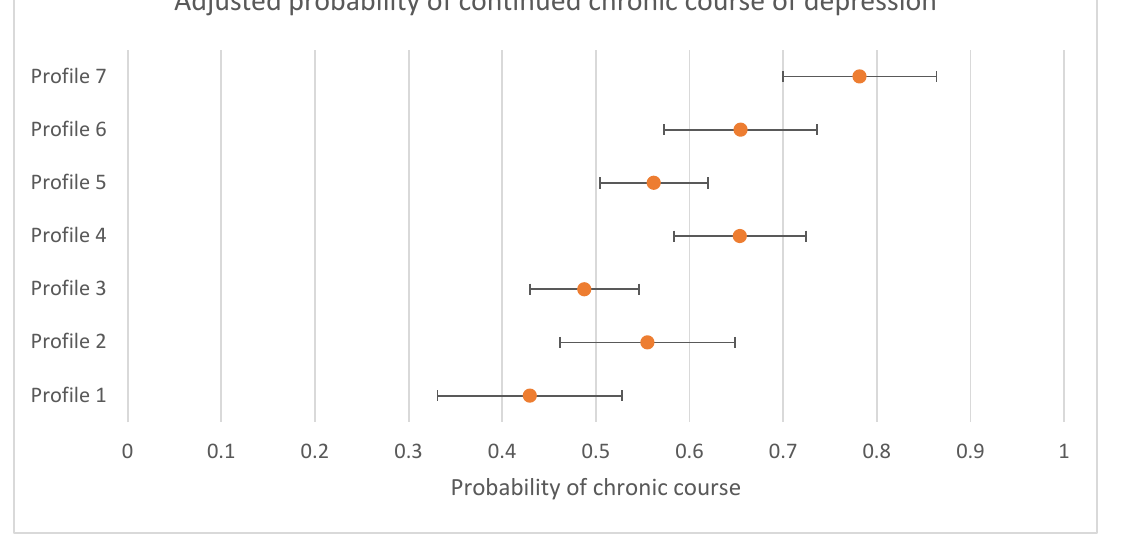
Figure 3. Adjusted probability of continued chronic course of depression by profile (probability and 95% CIs presented).